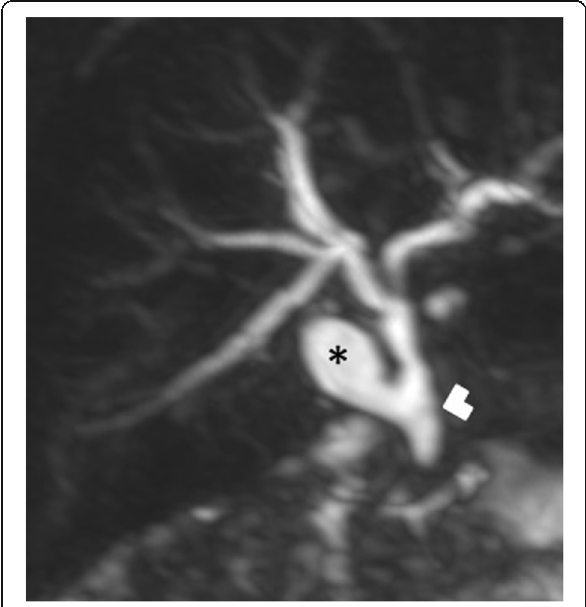
Fig. 8 A 2-year-old female patient presenting with jaundice. On the US, a saccular outpouching arising from the supraduodenal extrahepatic bile duct was found (not shown). Coronal plane MRCP MIP image shows a diverticulum (asterisk), arising from the supraduodenal extrahepatic bile duct